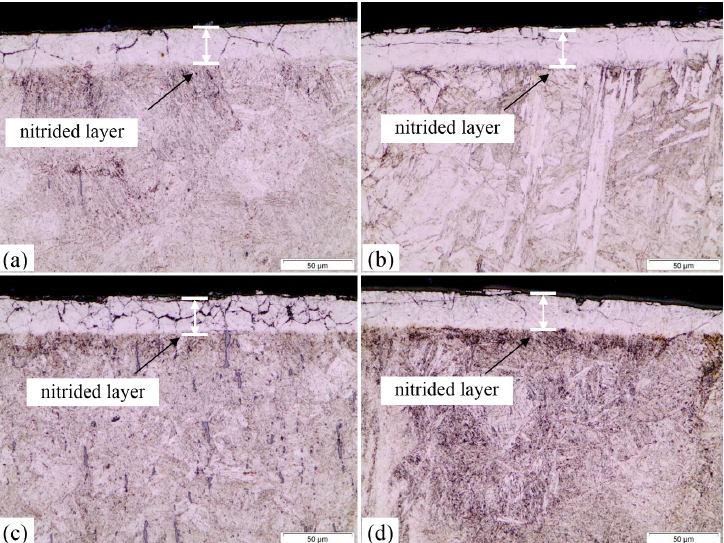
Figure 3. Cross-section micrographs of samples nitrided at 450°C: (a) AISI 410, (b) AISI 410NiMo, (c) AISI 416, and (d) AISI 420. Treatments carried out for 4 h, using a gas mixture composition of 70% N pressure of 3 Torr.